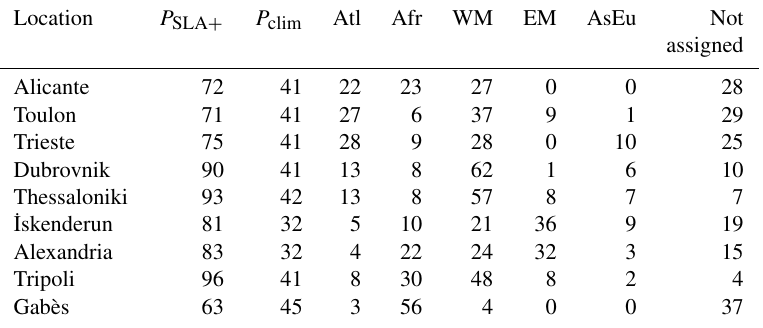
Table 2. Statistics of cyclones producing the 100 largest positive sea level anomalies in each considered station. The first two columns, labelled “ P SLA + ” and “ P clim ”, report the probability (%) of finding a cyclone within a 10 ◦ search radius from the reference point (denoted with a yellow square in Fig. 6) at the time of the event and the corresponding climatological mean value, respectively. Differences between the P SLA + and P clim values are statistically significant at the 95% level. The following columns (labelled Atl, Afr, WM, EM, AsEu) report the probability (%) that the cyclogenesis of the cyclone associated with the event occurred in the areas shown in Fig. 1. The last column reports the number of events in the period 1979–2001 that were not assigned to any cyclone. P SLA + P